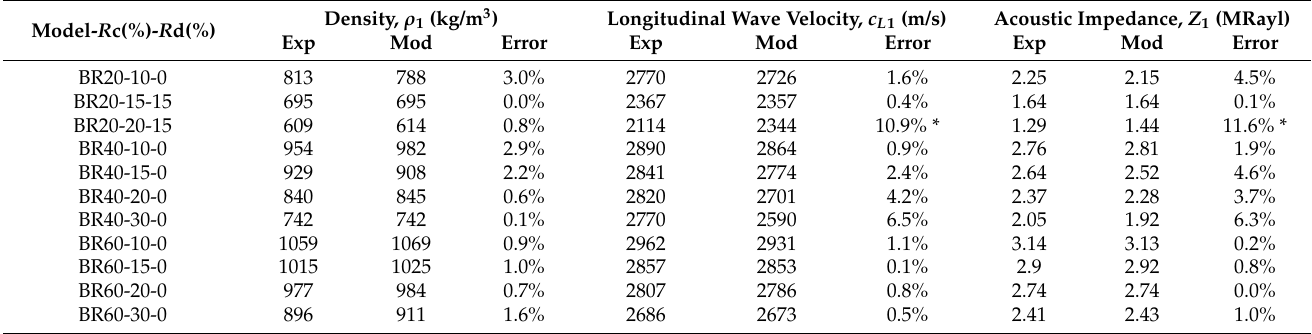
Table 3. First matching layer acoustic properties. (Exp-experiment,